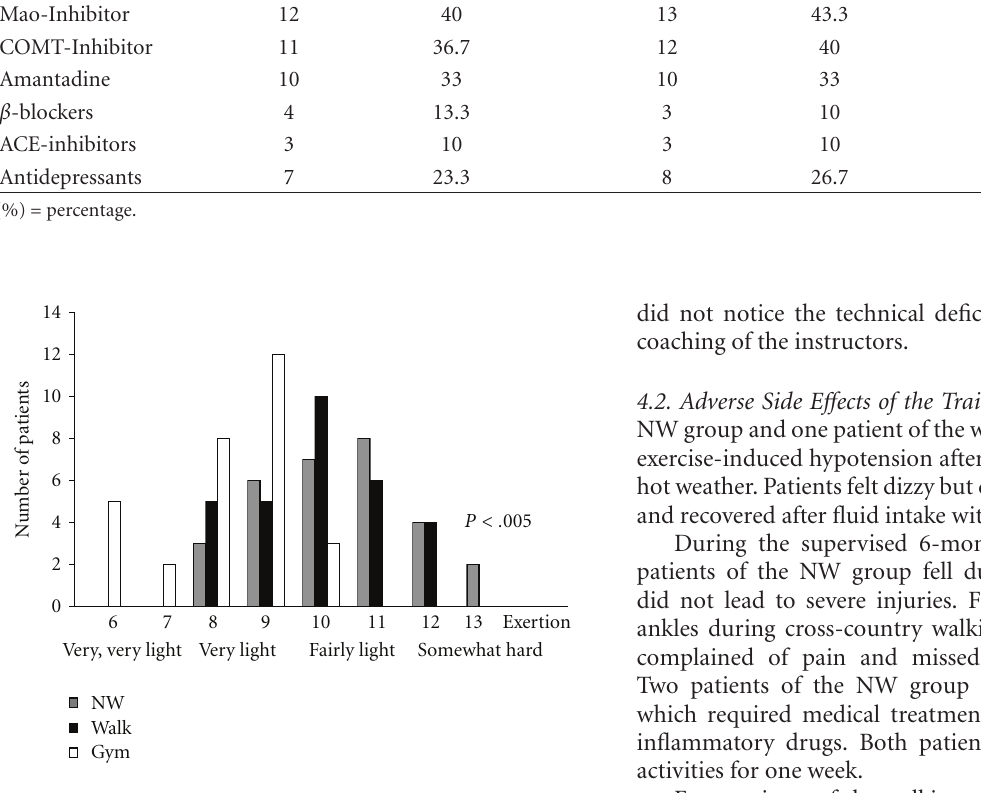
Figure 2: Borg scale: Patients of the Nordic walking group and walking group perceived more exertion than the flexibility and relaxation group suggesting that the training of both groups was more